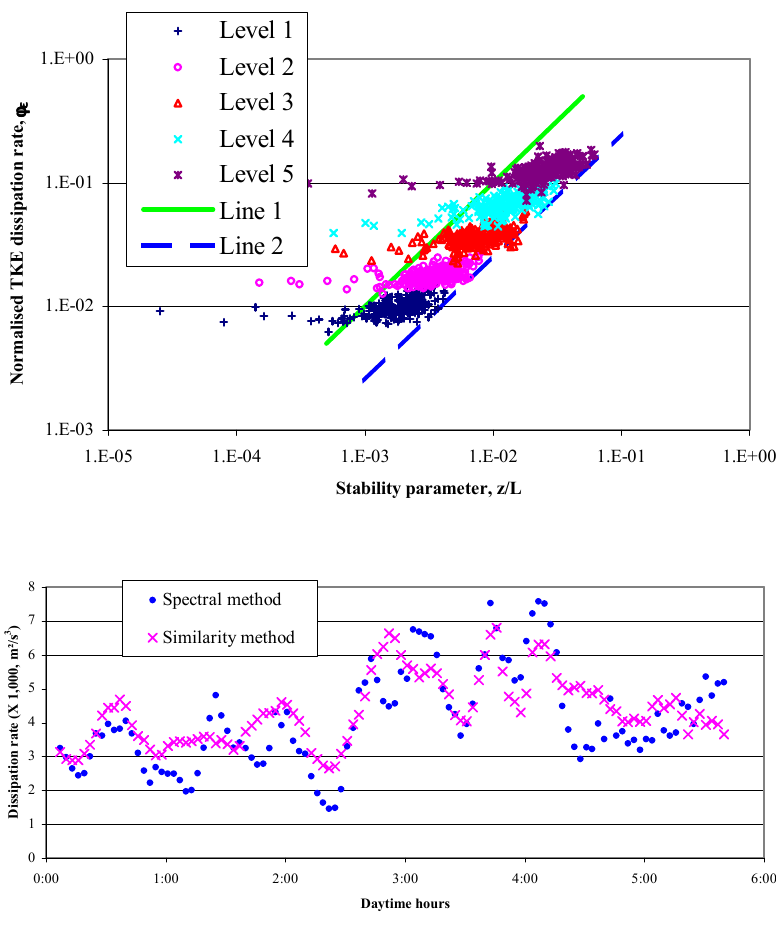
Fig. 12. TKE dissipation rate. Com- parison between the similarity (cross) and the spectral (dot) methods. Plot CT, level 5, 25 July 1997.